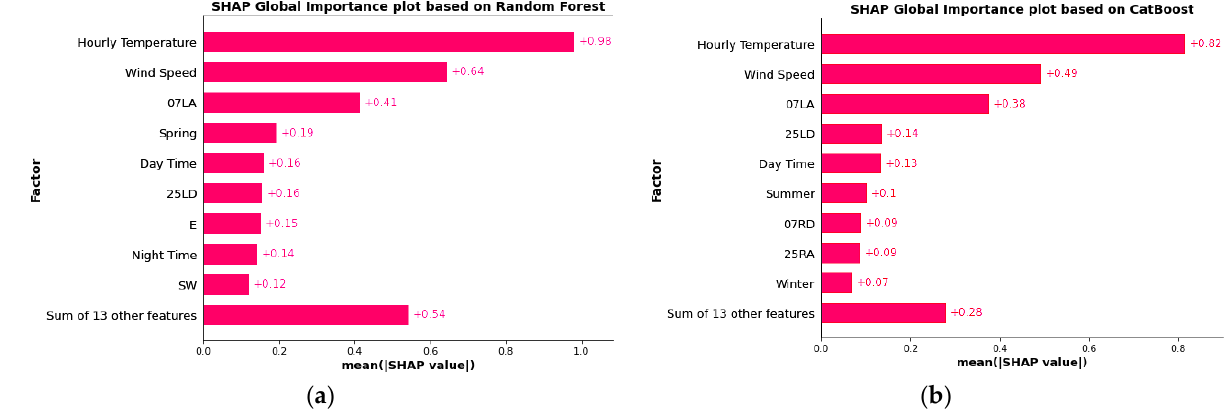
Figure 10. SHAP global importance plots: ( a ) Random Forest; ( b ) CatBoost. Similarly, a SHAP contribution evaluation was conducted to conduct a more in- depth examination of the Random Forest and CatBoost models using SHAP beeswarm plots (Figure 11). We created a quantitative value from the SHAP contribution plots that combined the Shaply values and expressed the classifier contributions of factors. The input factors were arranged on the vertical axis in order of increasing influence, starting with the most influential. The SHAP value is shown on the horizontal axis, and the significance of the factor is shown by the color scale, (blue to pinkish-red for low significance to high significance). The SHAP beeswarm plots of the Random Forest and CatBoost models illustrate that most of the moderate-to-high mean wind speeds resulted in the occurrence of C-LLWS events, which are represented by the pinkish-red color toward the right side of the vertical reference line with positive SHAP values (Figure 11a,b). The blue color toward the left of the vertical reference line indicates the occurrence of NC-LLWS events due to a low mean wind speed. Similarly, in the case of the mean hourly temperature, a high temperature (represented in red) is shown to the right of the vertical reference line with a positive SHAP value and blue to the left of the vertical reference line. It shows that high temperatures resulted in C-LLWS events while low temperatures were more likely to cause NC-LLWS events. The same was the case for wind speed and Runway 07LA.